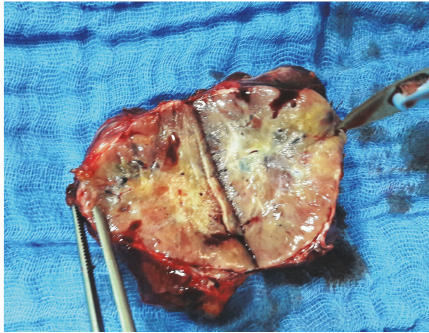
Figure 4: Cut gross specimen showing a tan colored mass.